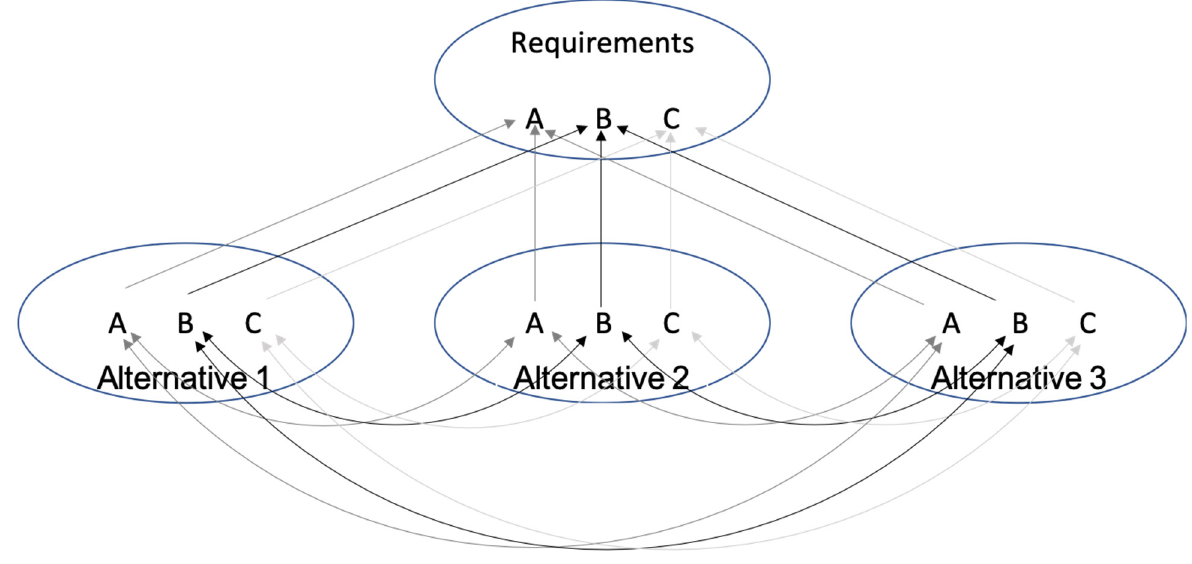
Figure 2. Ideal decision context against requirements.